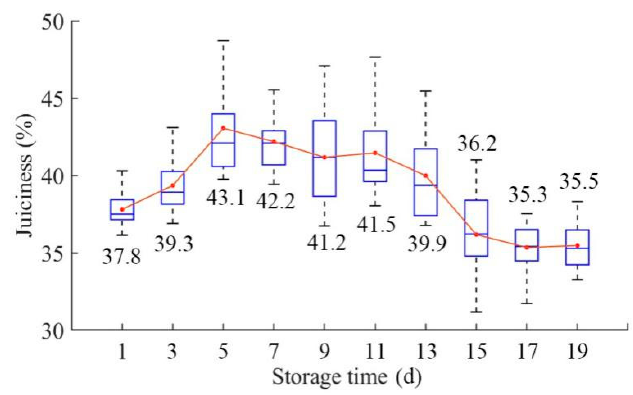
Figure 3. E ff ects of storage time on the juiciness of Figure 3. Effects of storage time on the juiciness of pears.